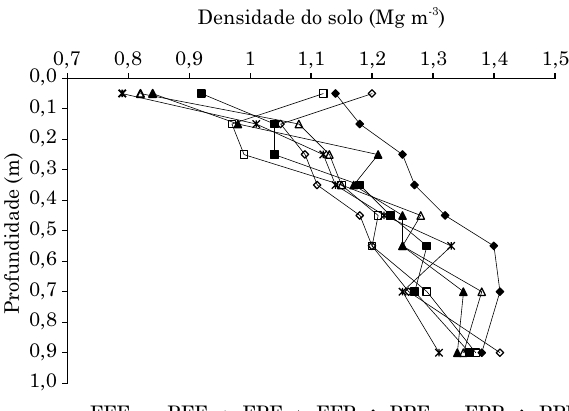
Figura 4. densidade do solo para os tratamentos FFF, PFF, FPF, FFP, PPF, FPP e PPP, em diferentes profundidades, em que FFF: uso com floresta a mais de 70 anos; FPF: área ocupada nos últimos 25 anos por floresta, antecedida por um período de 25 anos por pastagem e anteriormente por floresta; PFF: uso com florestas nos últimos 50 anos e pastagem no período anterior a 1957; PPF área ocupada nos últimos 25 anos com floresta, antecedida por pastagem; PPP uso com pastagem a mais de 70 anos; FFP uso com pastagem nos últimos 25 anos; e FPP: uso com pastagem nos últimos 25 anos.